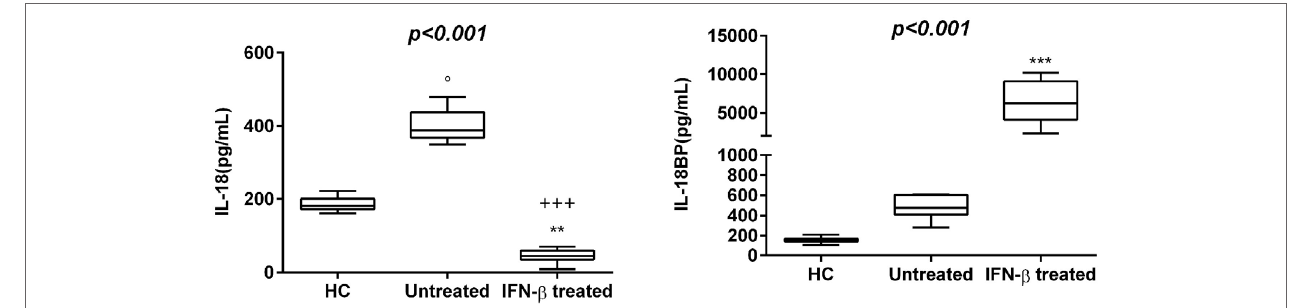
FigUre 2 | Box–whisker graphs of interleukin (IL)-18 and IL-18 binding protein (IL-18BP) levels in the three study groups. Box–whisker plots show the 25th and 75th percentile range (box) with Tukey 95% confidence intervals (whiskers) and median values (transverse lines in the box). +++ p < 0.001 interferon (IFN)- β -treated vs untreated; o p < 0.05 untreated vs healthy controls (HC); and ** p < 0.01, *** p < 0.001 IFN- β -treated vs HC of post hoc analysis. p -Value reported in figures are relative to Kruskal–Wallis H